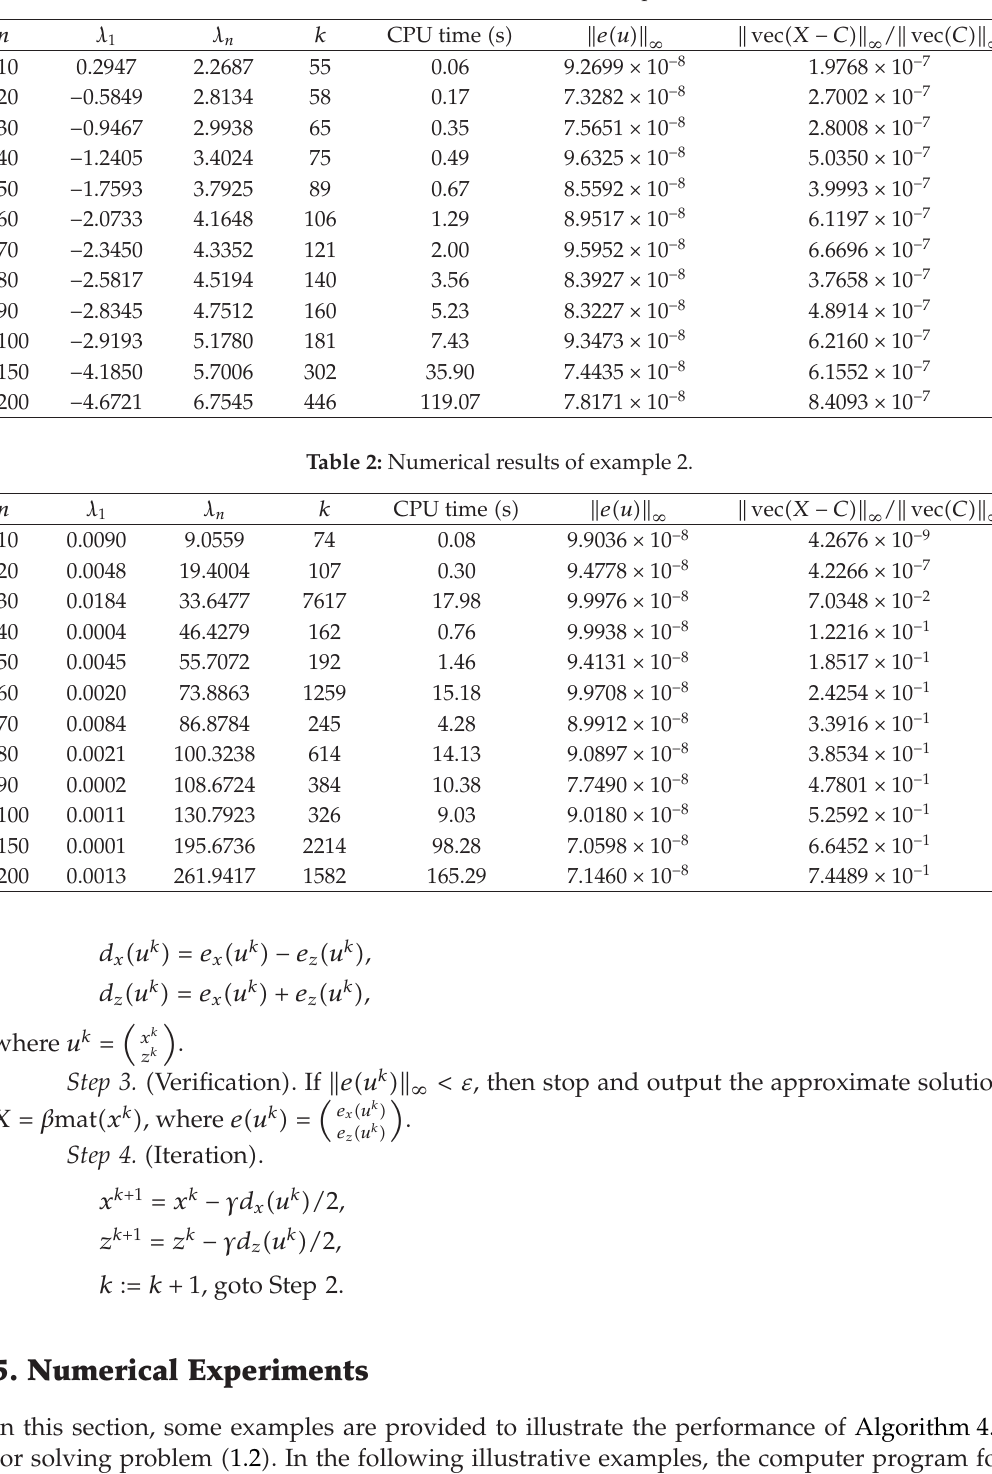
Table 1: Numerical results of example 1.